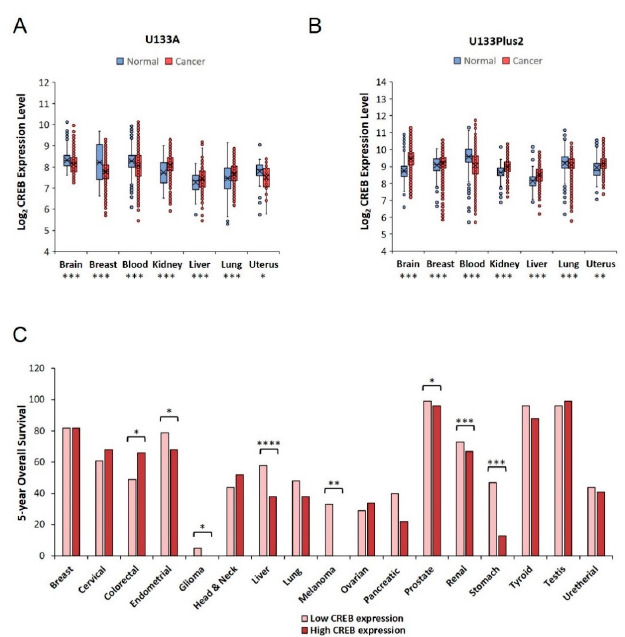
Figure 1. CREB expression levels in healthy and cancer patients. Gene Expression database of Normal and Tumor tissues 2 (GENT2) open access database (http: // gent2.appex.kr) was employed to evaluate CREB expression levels in cancer and non-cancer tissues within A ff ymetrix U133A ( A ) and U133Plus2 ( B ) platforms. The significantly shared groups between these two distinct microarrays are plotted as tissue boxplots. ( C ) Based on CREB mRNA content, Kaplan–Meier plots of seventeen types of tumor were analyzed using the interactive open-access Human Protein Atlas (HPA) database (www.proteinatlas.org / pathology). For each analyzed cancer type, median five-year overall survival values of both stratified groups are plotted as columns in the histogram graph. * p < 0.05, ** p < 0.01, *** p < 0.001, **** p < 0.0001 by two-sample t